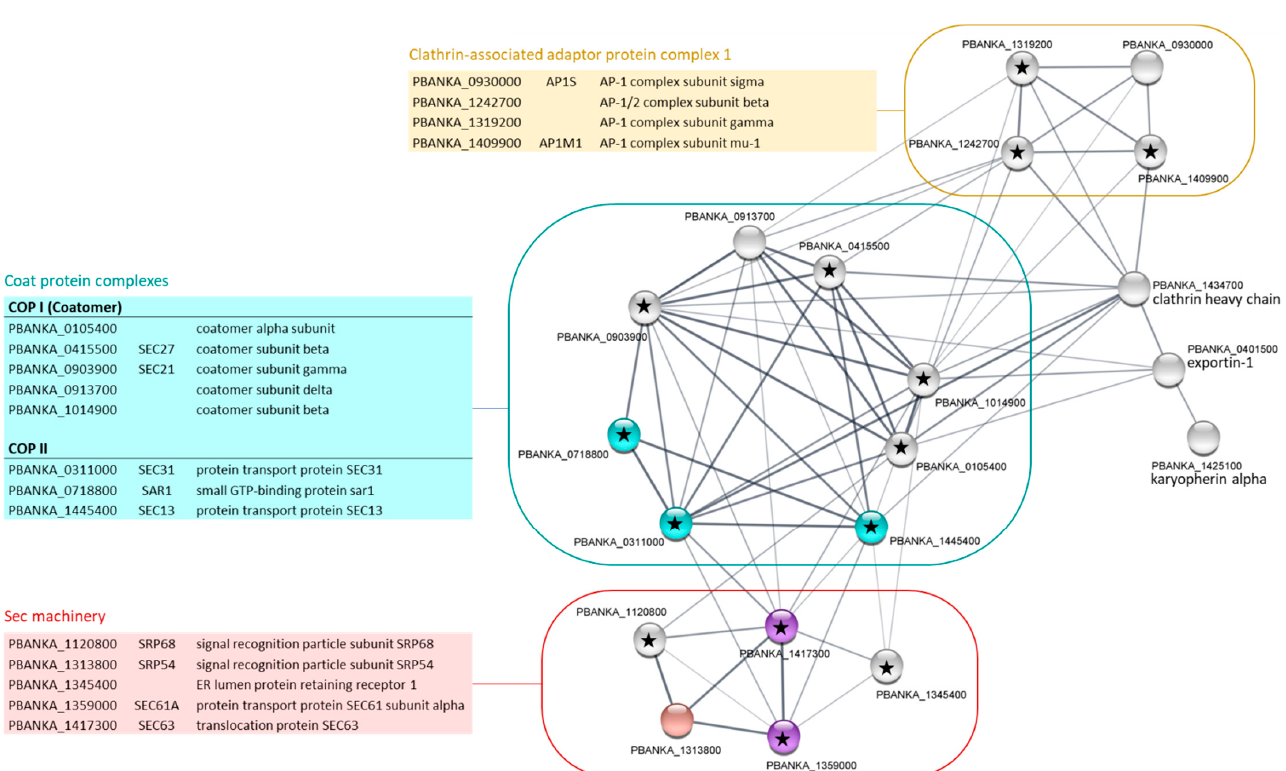
Figure 5. STRING network visualization of PbPP1c-interacting proteins belonging to “protein transport” GO Slim in gametocyte stages. Using the Cytoscape STRING application, a network was retrieved for the 24 proteins from the protein transport GO Slim of the PbPP1c interactome in gametocyte stages. With a protein–protein interaction enrichment p -value < 1 × 10 − 16 , the resulting network contained 69 functional associations among 20 proteins; four proteins (i.e., PBANKA_0912200, signal recognition particle subunit SRP72; PBANKA_0931200, heat shock protein 101; PBANKA_1217800, signal peptidase complex subunit 2; PBANKA_1359100, nuclear import protein MOG1) with no associations to other proteins in the network were removed. Proteins from KEGG pathways map03060 (protein export) and map04141 (protein processing in endoplasmic reticulum) are colored in blue and red, respectively. Proteins from both of these KEGG pathways are colored in purple. Assignation to coat protein complexes, clathrin-associated adaptor protein complex 1 and to Sec machinery was conducted manually based on protein description in the PlasmoDB and literature. Black stars indicate proteins with RVxF motifs based on the Wakula consensus sequence [19] . Proteins of each network are listed in adjacent tables showing PlasmoDB geneID, short name, and protein description. STRING analysis was performed using the 11.0b version of the database.